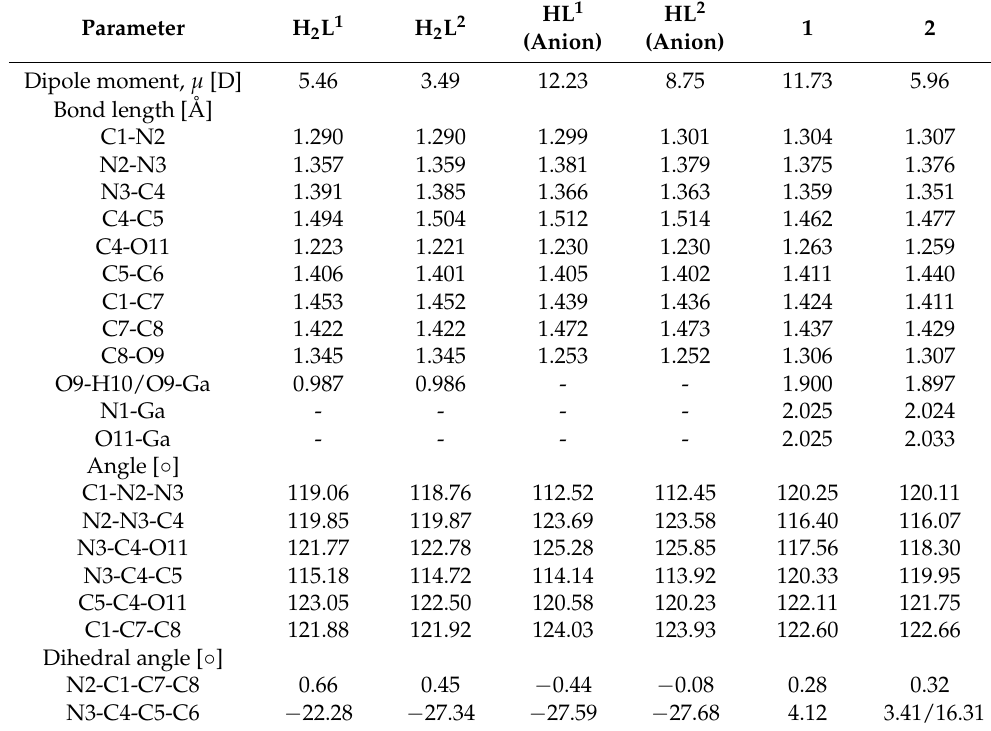
Table 1. Selected B3LYP/6-31+G(d,p) calculated parameters for the ligands and Ga(III) complexes.